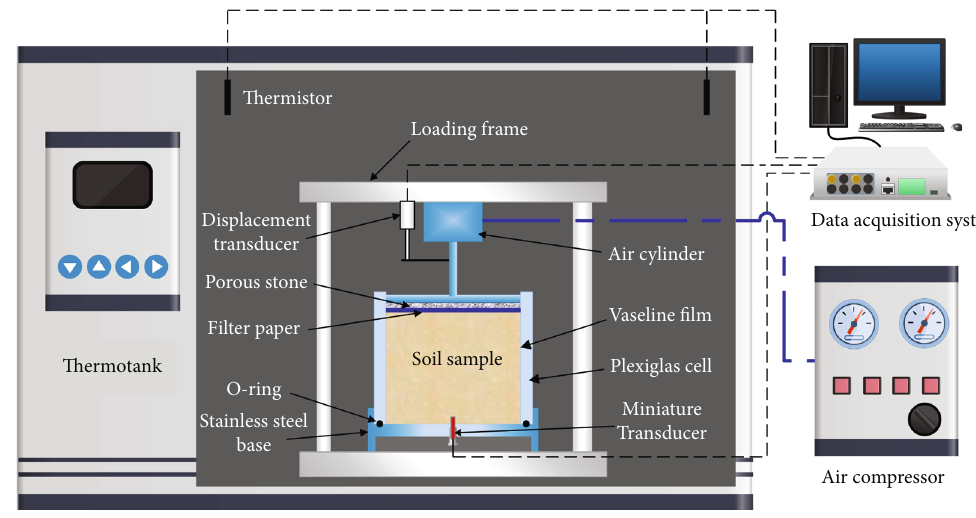
Figure 4: Test system.